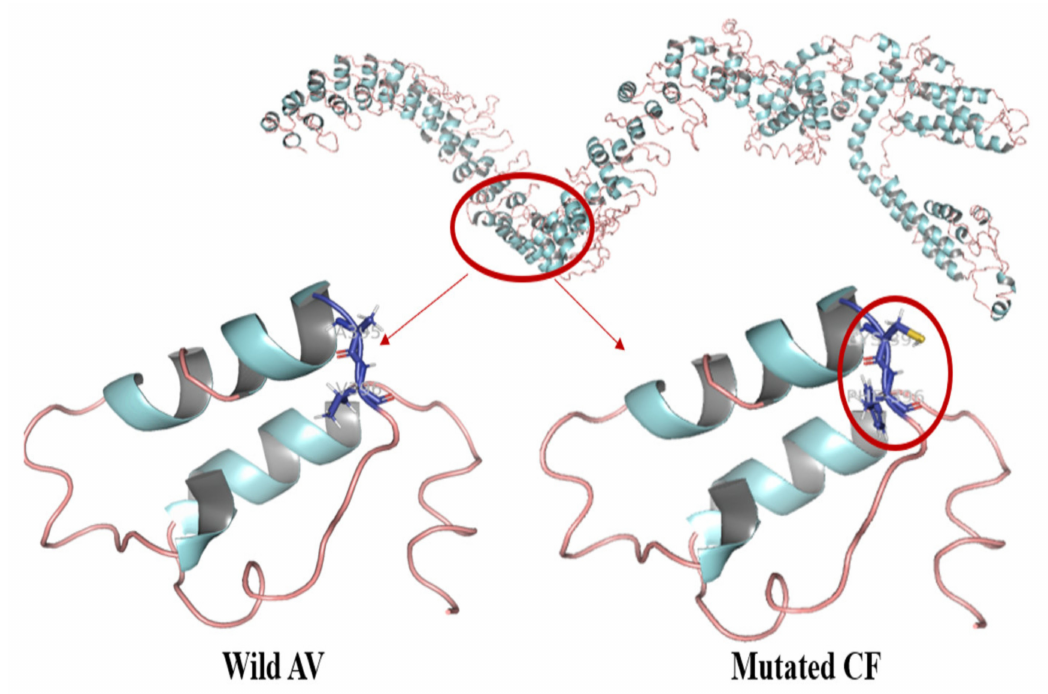
Figure 2. Protein modeling studies of normal wild-type and mutated